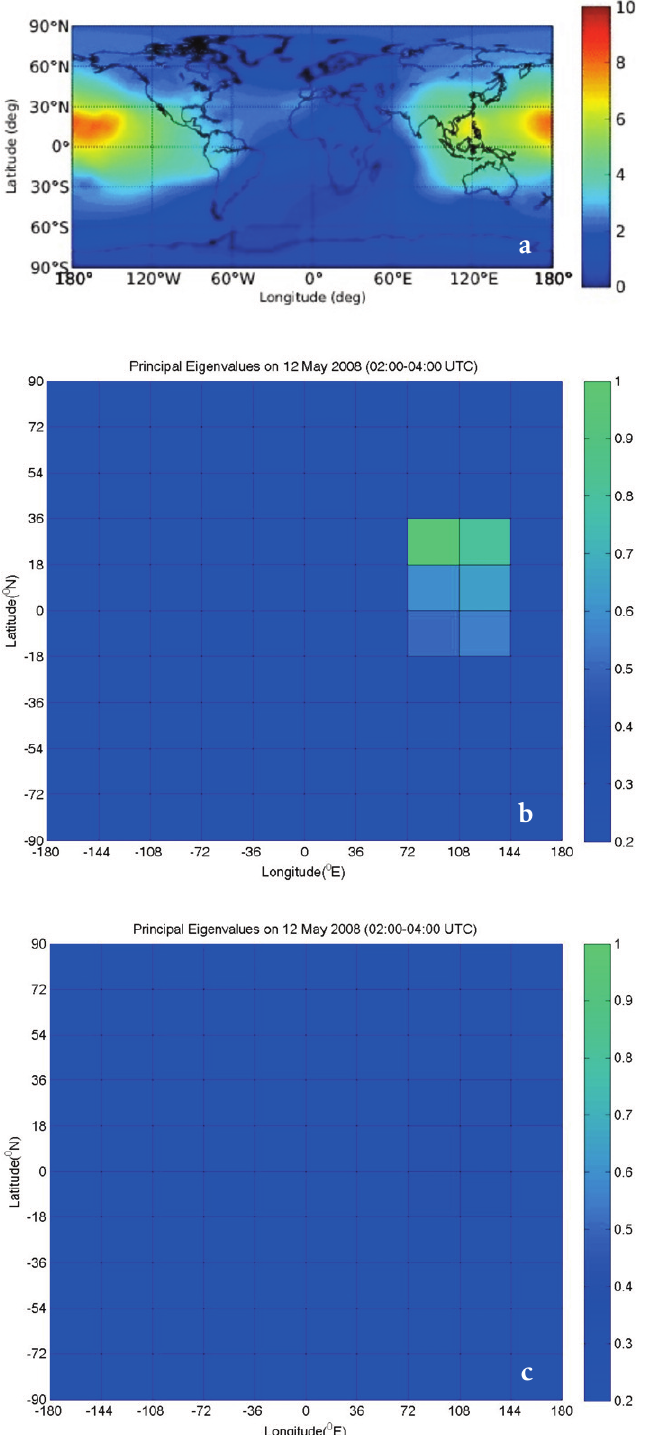
Figure 2. (a) The GIM on May 12, 2008, at heights of 150 km to 450 km for the time period 02:00-04:00UT. (b, c) Color-coded scales of the magnitudes of principal eigenvalues using NLPCA (b) and PCA (c) corresponding to (a). See Figure 1, legend for further details.